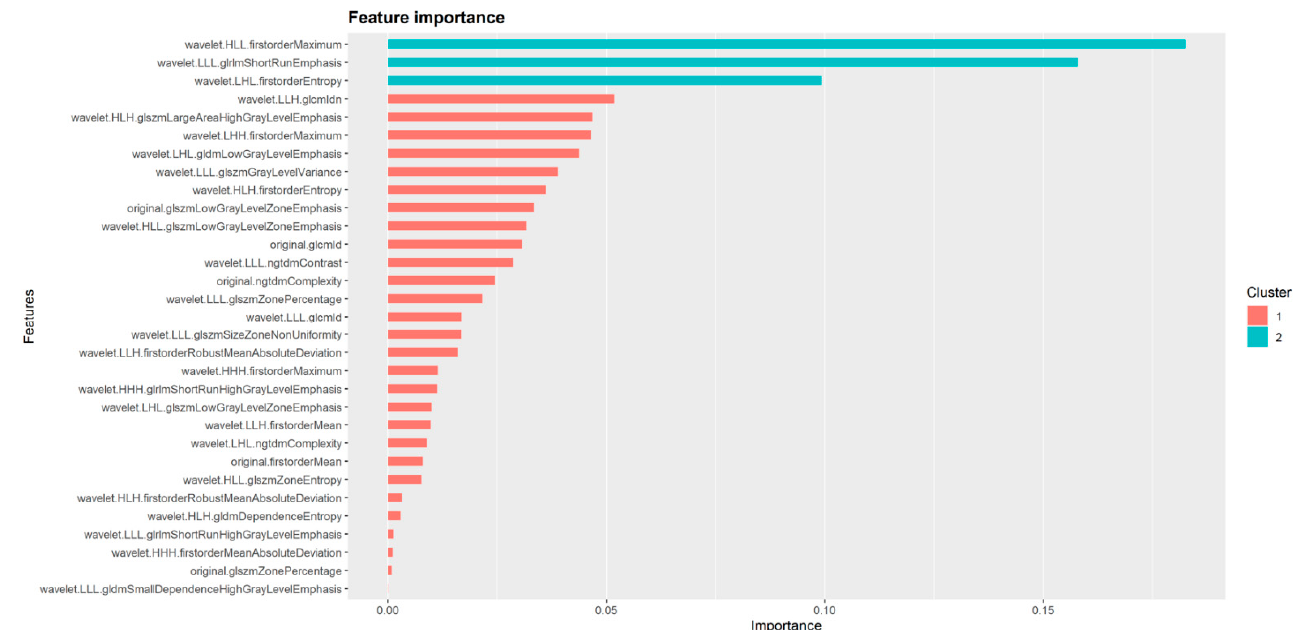
Figure 5. Radiomics features identified as important for the performance of XGboost. Important features belong to two clusters based on their degree of importance. Cluster 2 contains three features which represent the most important determinants of XGboost performance in differentiating between TOH and AVN. Table 2. Performance of the three machine learning algorithms.